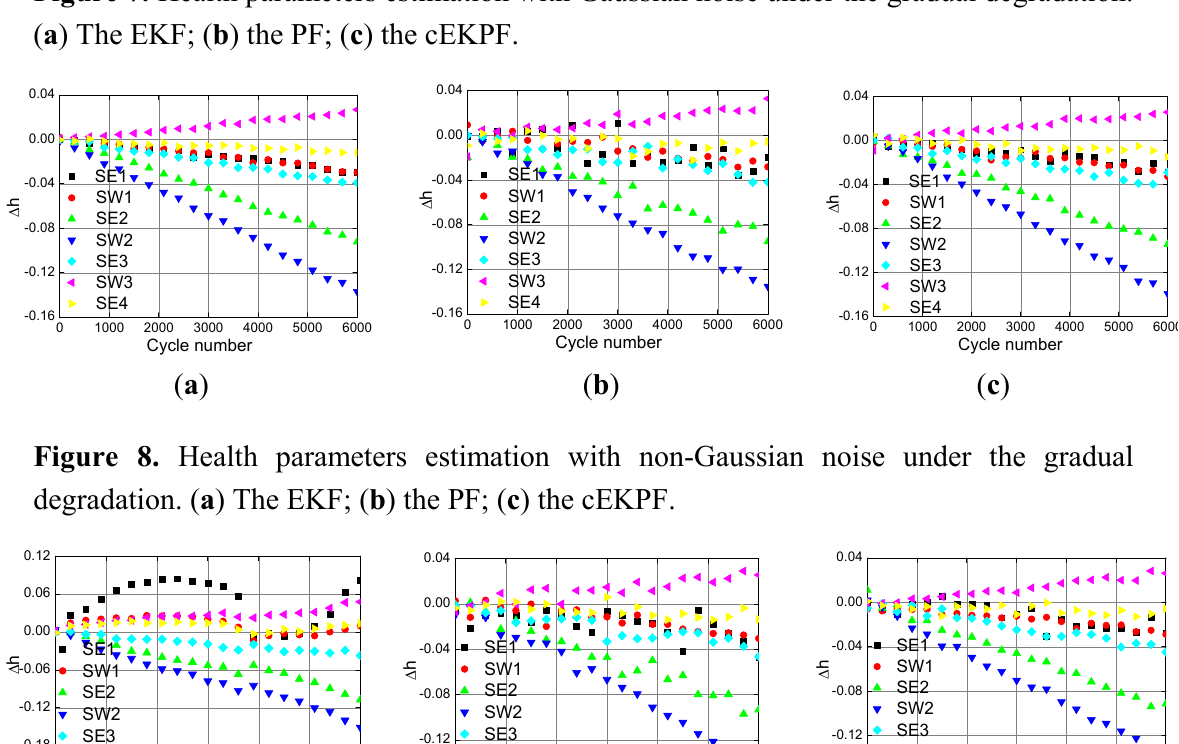
Figure 7. Health parameters estimation with Gaussian noise under the gradual degradation.